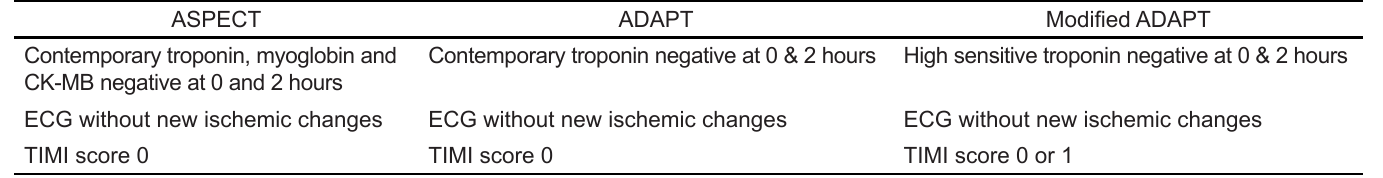
Table 1. Low-risk patients as classified in the ASPECT, ADAPT and APACE trial. 6,7,8